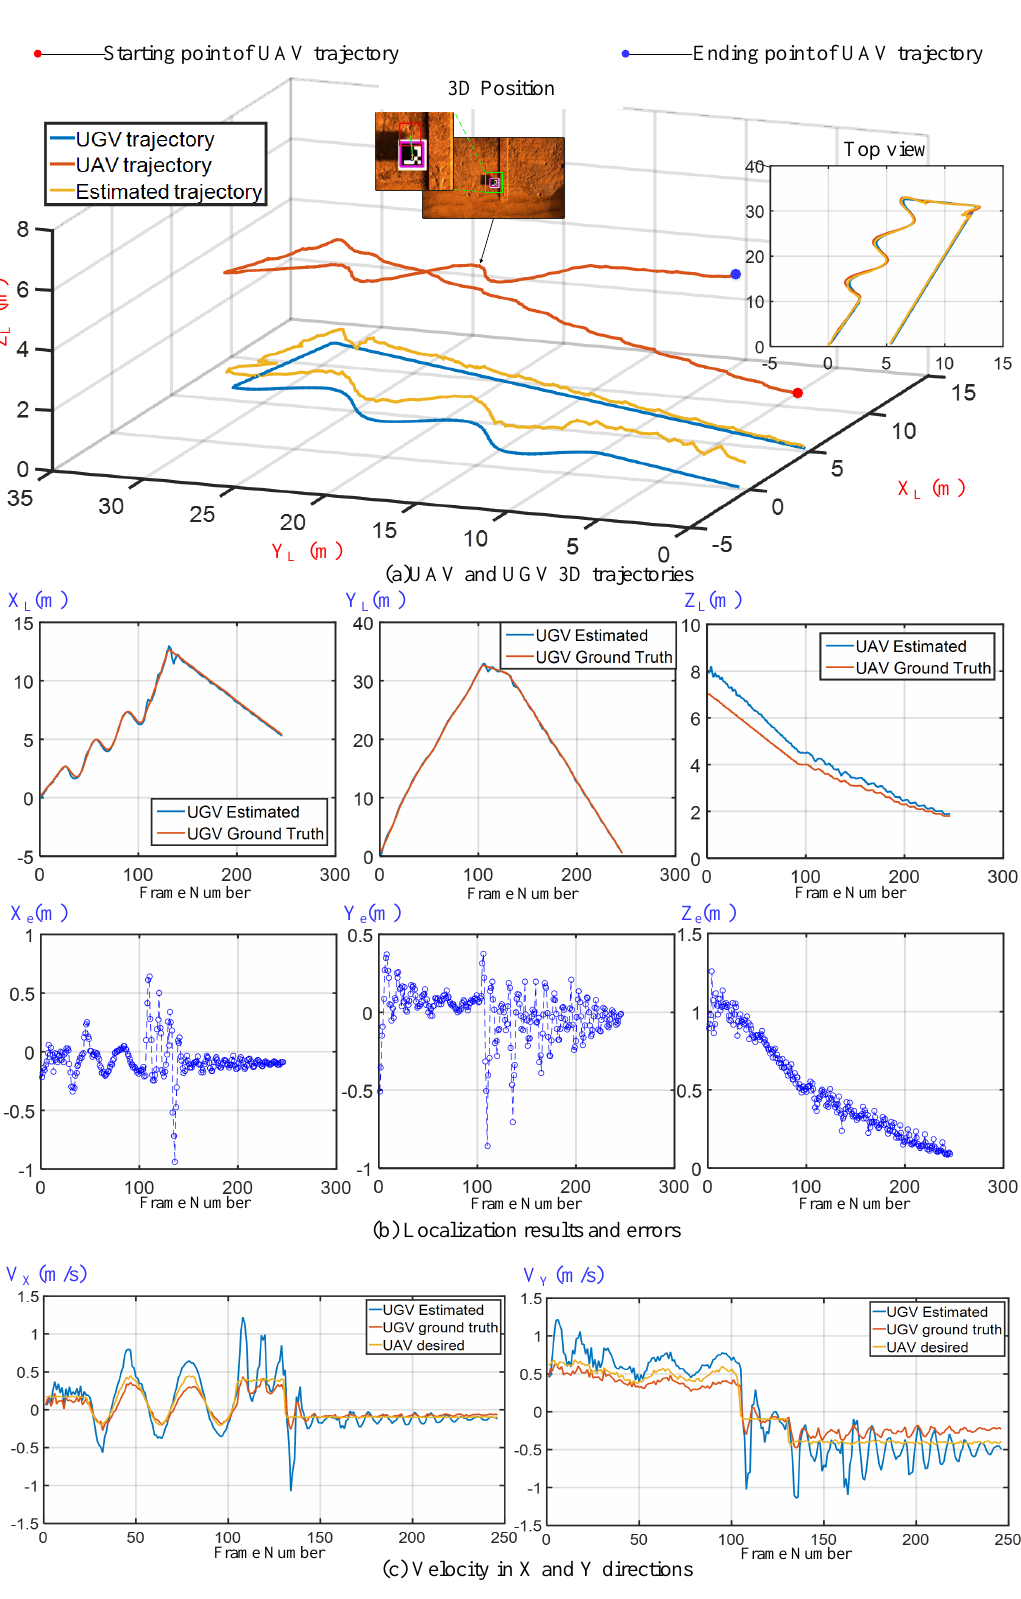
Figure 8. The results of the quantitative analysis simulation. ( a ) UAV and UGV 3D trajectories; ( b ) The localization results and errors in the X, Y, and Z coordinates; ( c ) The velocities of the UGV in both X and Y directions. In the figure, X L , Y L , and Z L respectively represent the localization in the X, Y, and Z directions; X e , Y e , and Z e represent the localization errors in the X, Y, and Z directions; V X , V Y represent the velocity in the X, Y